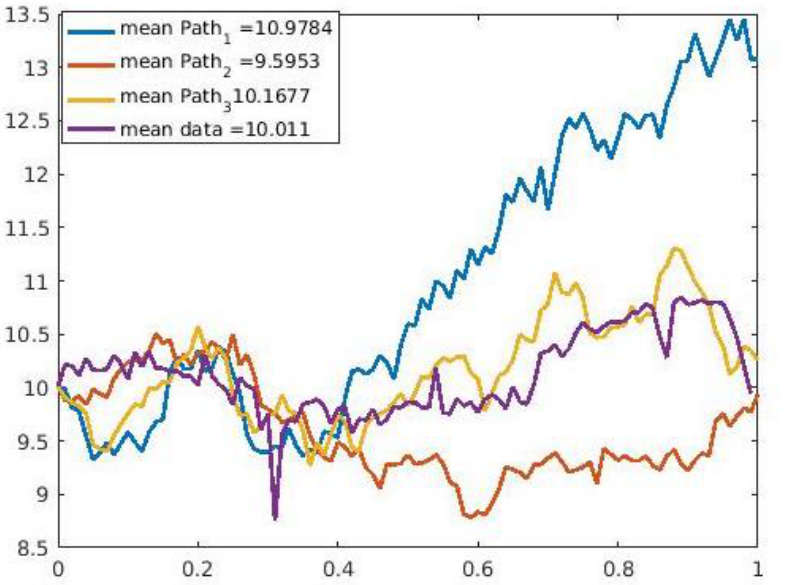
Figure 9. Graph showing three sample paths and time series plot for eruption 2. We observe from the sample paths that sample path 3 closely predicts the time series and see by comparison of the means that sample path 3 is closer in value to the mean of the time series data.